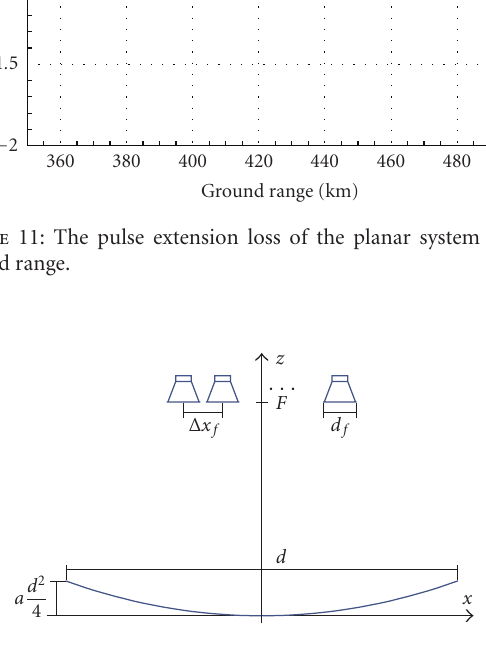
Figure 12: C-Band reflector and feed array geometry.